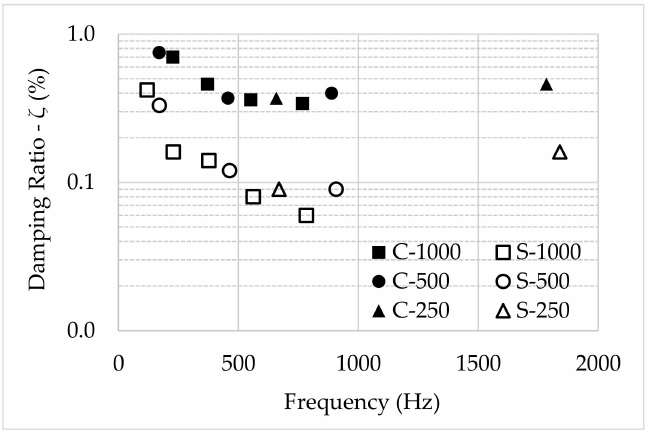
Figure 17. Damping ratio vs. frequency for different materials and lengths.